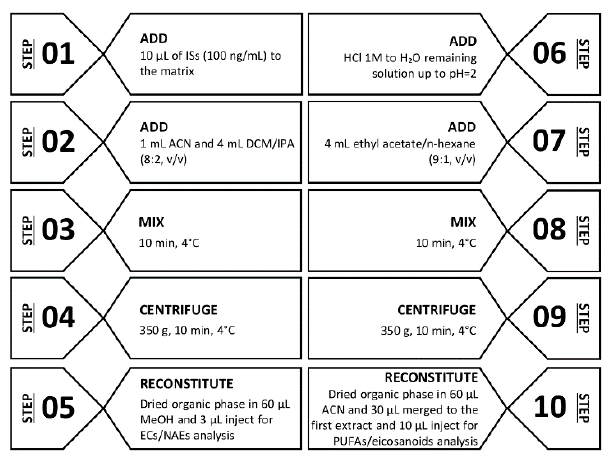
Figure 1. Diagram of the LLE procedure for ECs / NAEs (step 1–5) and PUFAs / eicosanoids (step 6–10). Abbreviations: internal standards (ISs), acetonitrile (ACN), dichloromethane / isopropanol (DCM / IPA), methanol (MeOH), endocannabinoids (ECs), N -acylethanolamides (NAEs), polyunsaturated fatty acids (PUFAs).